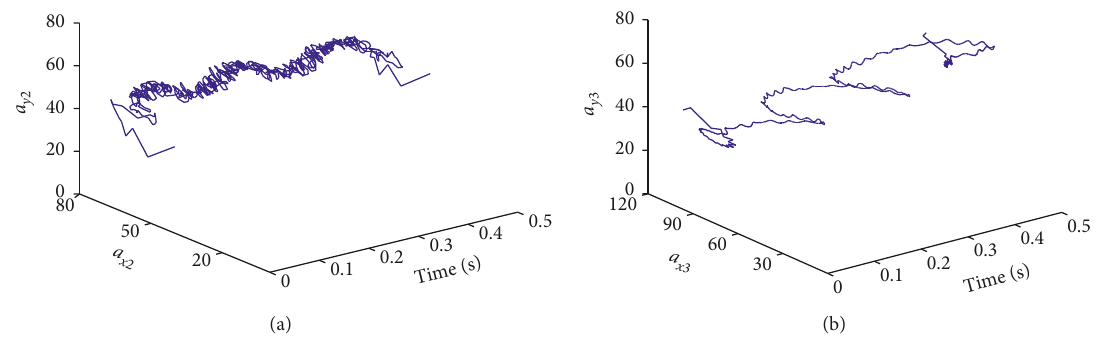
Figure 12: The 3D time domain of instantaneous amplitude was made up of (a) a